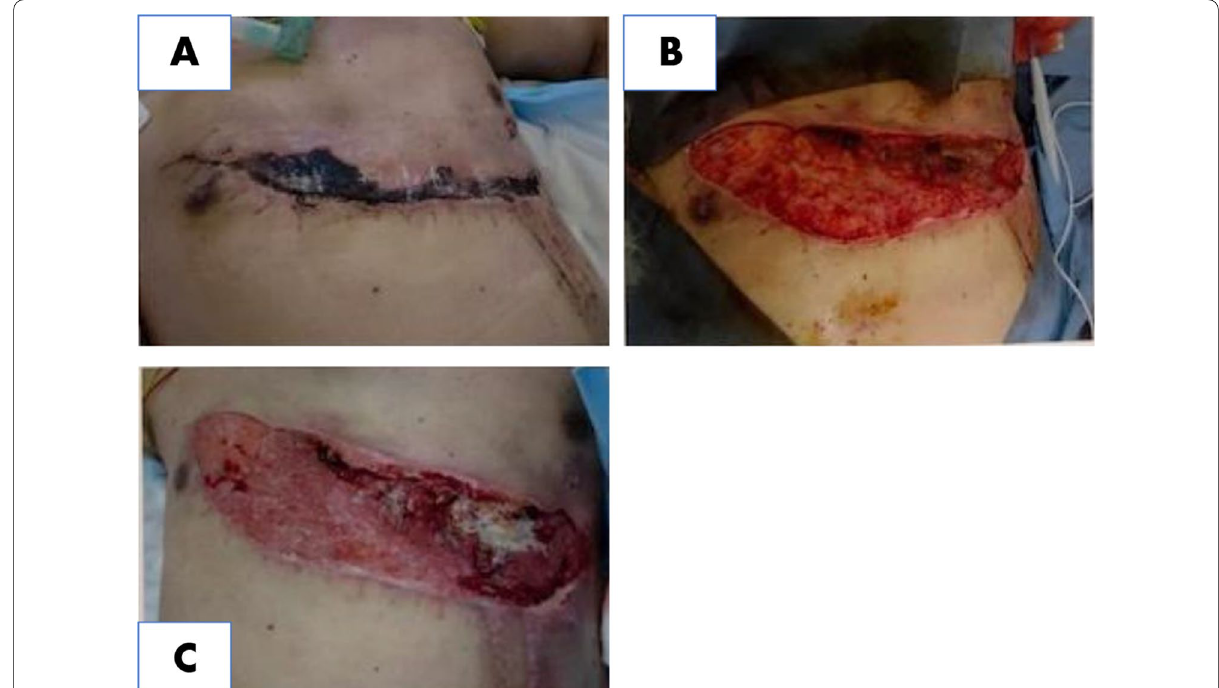
Fig. 5 A Partial necrosis of the wound, 13 days after initial operation. B Wound after debridement, 13 days after initial operation. C Defective granulation regenerated, 23 days after initial